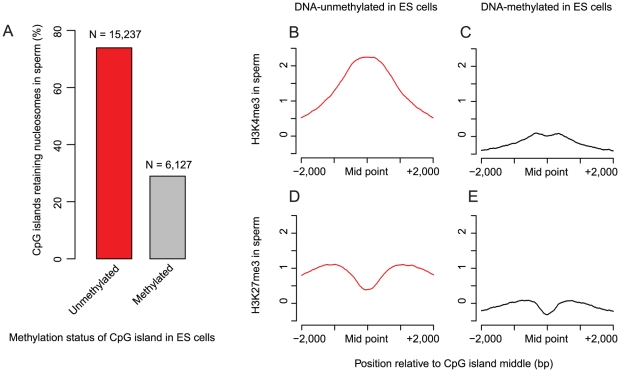
Nucleosome retention in sperm is linked to the formation of DNA methylation-free regions in the early embryo.Most (74%, 11,264/15,237) CpG islands that remain unmethylated in ES cells overlap nucleosome retention sites in sperm. In contrast, only 29% (1774/6,127) of the CpG islands that are methylated in ES cells overlap sperm nucleosome retention sites (A). CpG islands that are unmethylated in ES cells are enriched for H3K4me3 in mature sperm (B) compared to CpG islands that are methylated in ES cells (C). H3K27me3 shows moderate enrichment in sperm around CpG islands that are unmethylated in ES cells (D) compared to around CpG islands that are DNA methylated in ES cells (E).